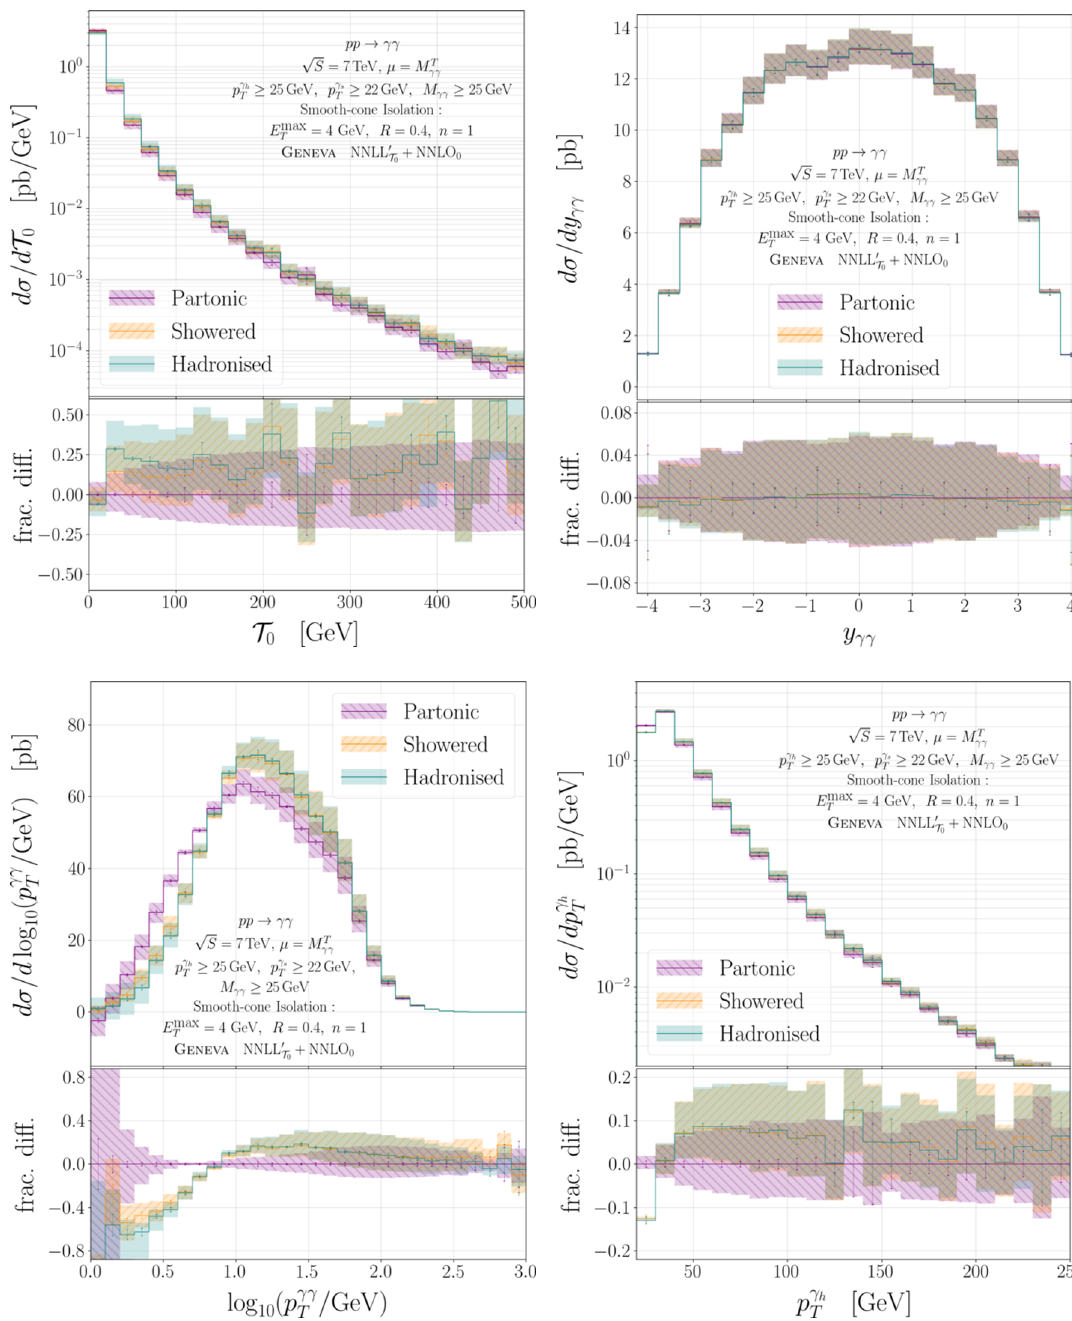
Figure 11 . Comparison between the partonic, showered and hadronised spectra after the inclusion of the gg channel